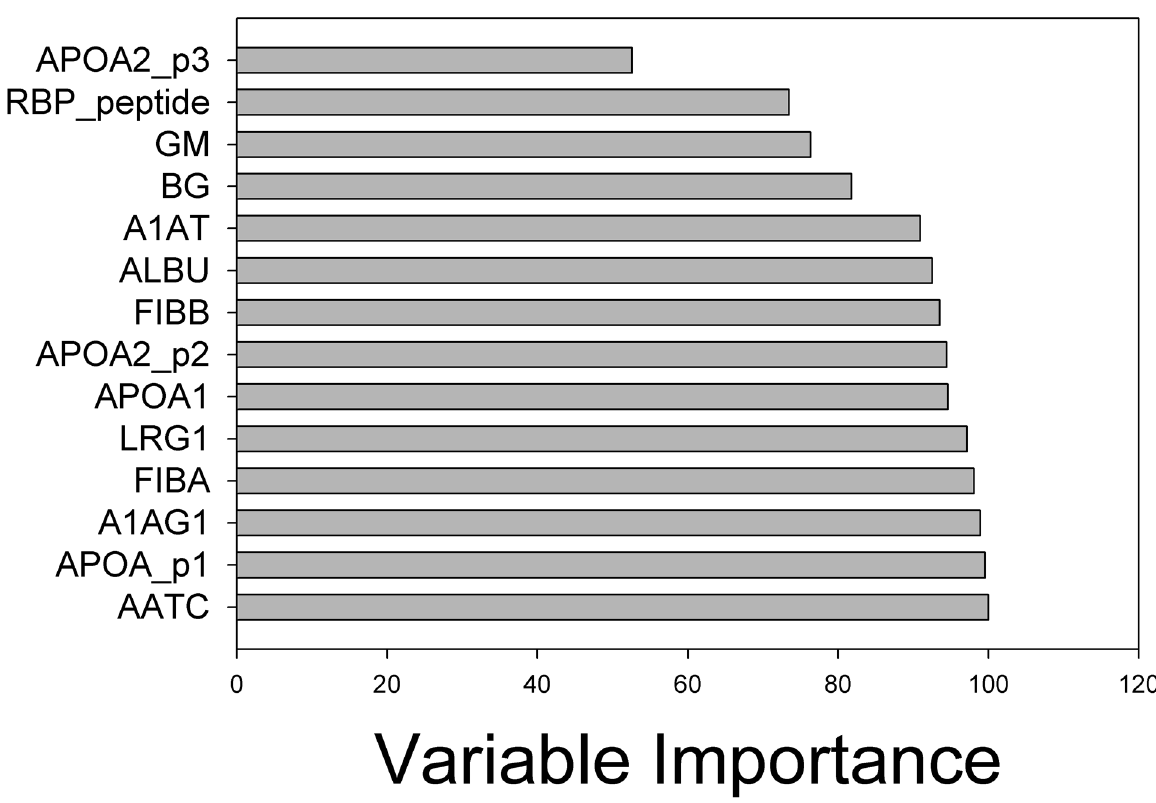
Fig 4. Candidate variable importance of the RF IPA model. Variable importance is a relative measurement from 0 – 100% that indicates the level that each marker contributes to the performance of the classifier. Note the top three important variables are host response